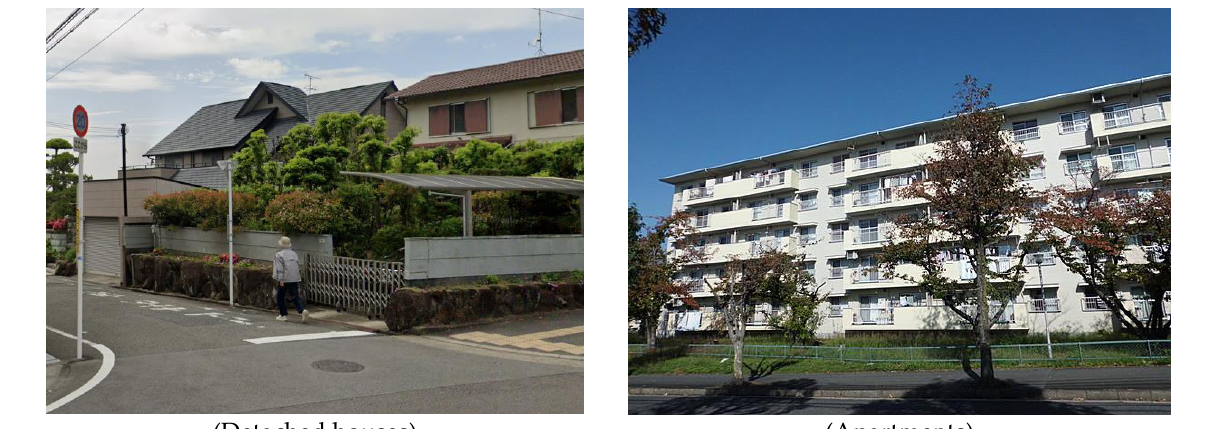
Figure 1. Examples of each housing type.